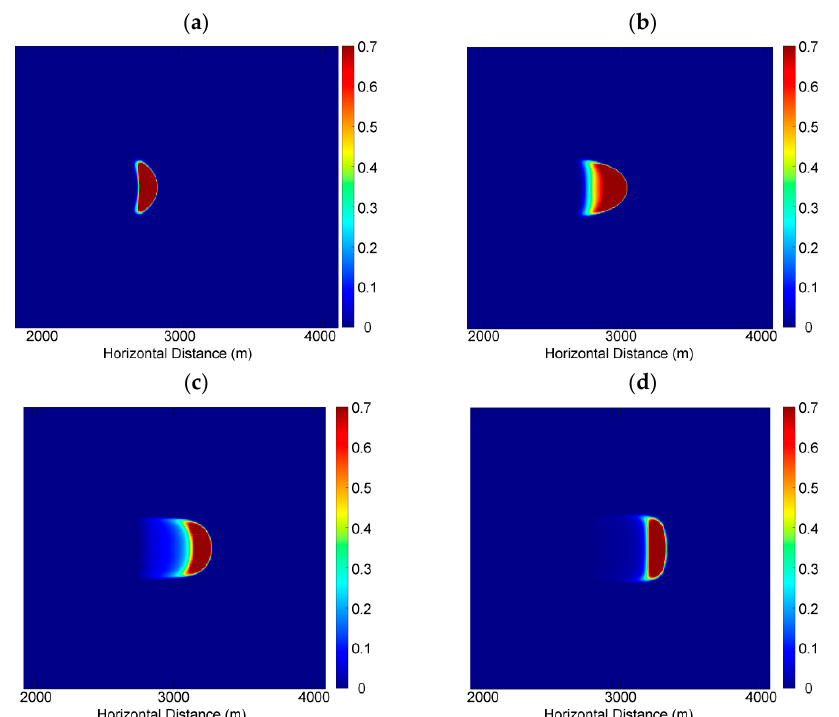
Figure 5. The final resting shape of the flows. Colored bars show the flow thickness in meters. The shape variation depending on the particle diameter was simulated with the I -dependent model on the 47° slope (at the release position). Cylindrical granular piles were set at the release positions initially and the flow started automatically. The particle diameters are ( a ) 10 cm, ( b ) 1 cm, ( c ) 1 mm, and ( d ) 0.1 mm. Table 1. Width and tail length of the final resting shape of simulated granular flows. The width and tail length are measured using the simulation results shown in Figure 5.